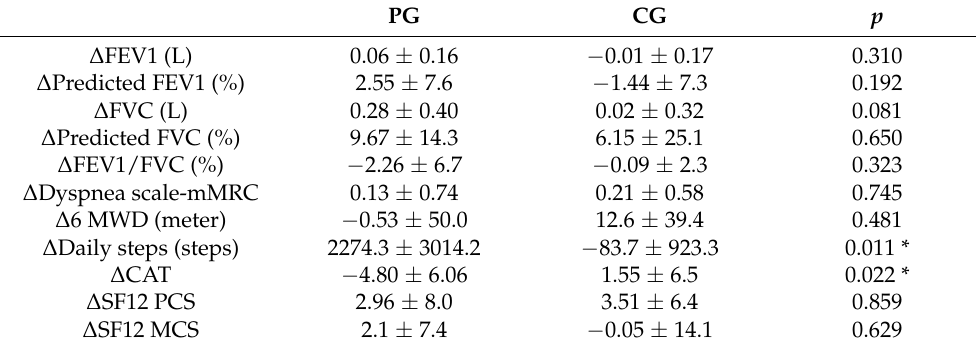
6 MWD: 6 min walking distance. SF12 PCS: Short form 12 Phyisologic component section. SF12 PCS. Short form 12 Mental component section. *: p < 0.05.